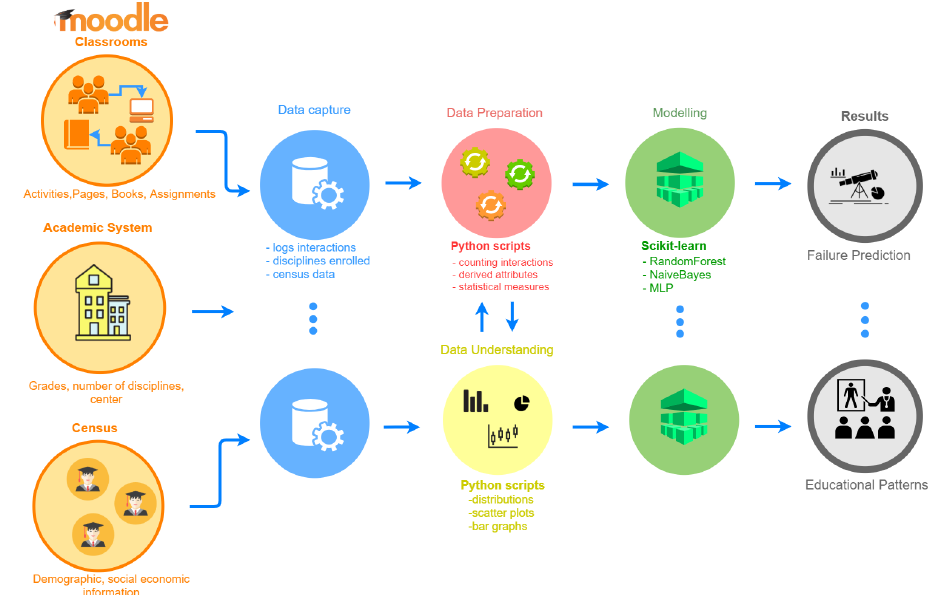
Figure 2. The proposed